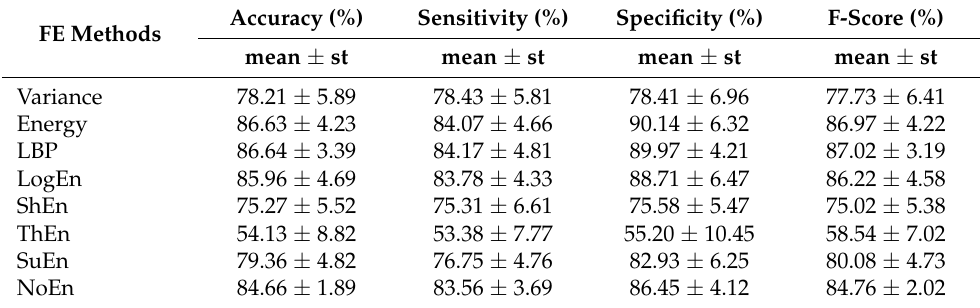
Table 4. Classification results of off–PD vs. HC using KNN classifier (without CSP).